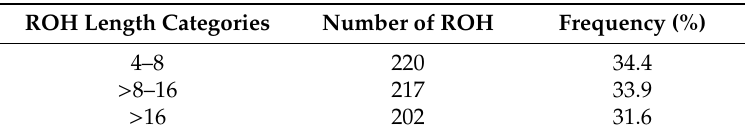
Table 1. Descriptive statistics of the number (N) and the frequency distribution of ROH in di ff erent length categories (Mb) in Ramo Grande.